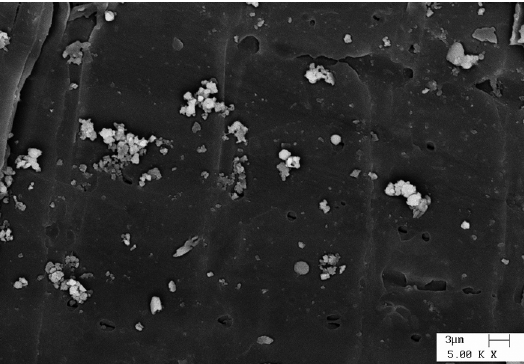
Figure 5. EDS spectrum of the cellular structure after treatment with